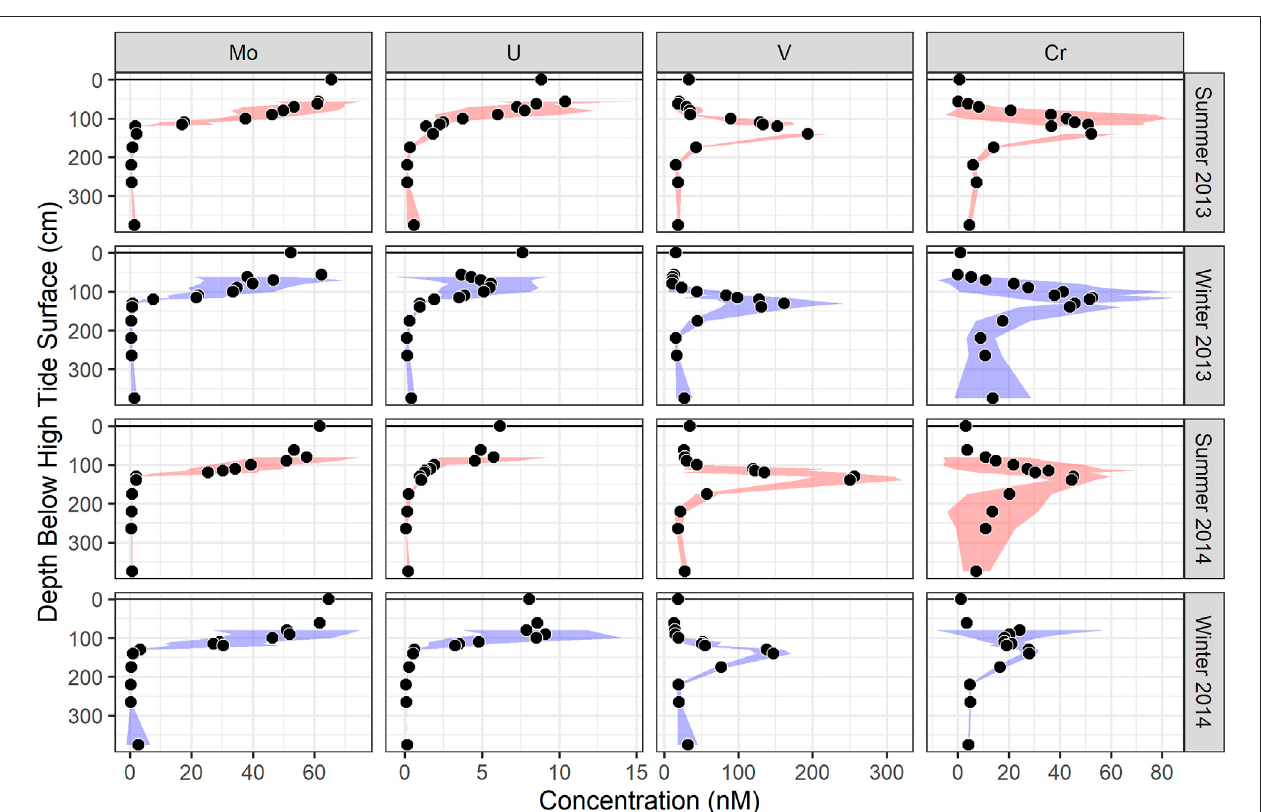
FIGURE 2 | Dissolved (A) Mo, (B) U, (C) V, and (D) Cr concentrations from the MT pro fi le over the 2-year time series. Summer is de fi ned as May to October, and winter is de fi ned as November to April. At each depth, the fi lled circles represent the mean, and shaded areas represent one standard deviation, of all the months sampled in each season.